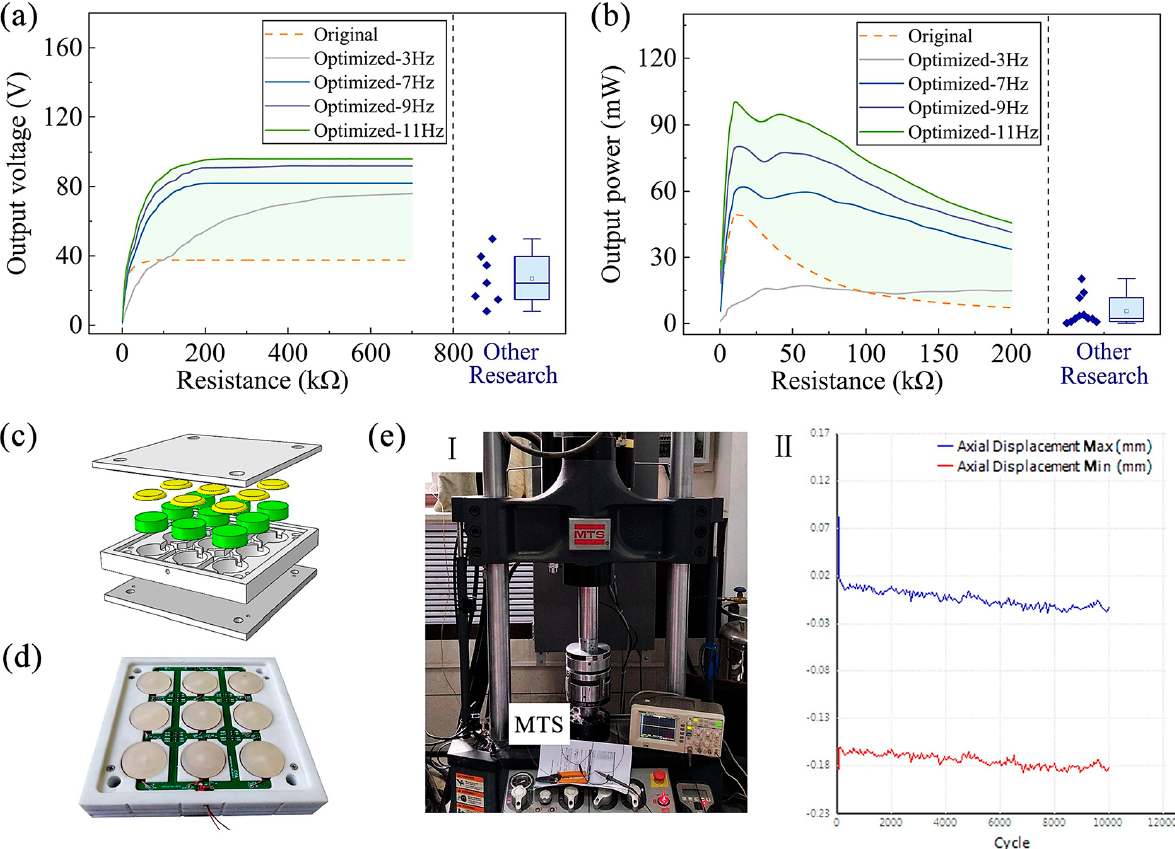
Figure 10. Piezoelectric device presented by Yuan et al. (2022): ( a ) output voltage vs. load resistance characteristic; ( b ) output power vs. load resistance characteristic; ( c ) 3D model; ( d ) realized prototype; ( e ) device under test ( I ) and trend of axial displacement as a function of stress cycles ( II ) (Reprinted with permission from Ref. [41]. 2022, Elsevier)